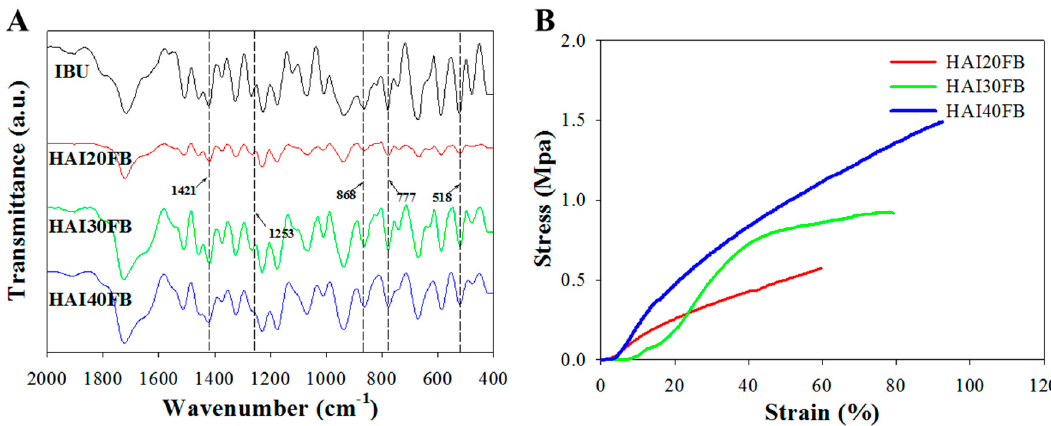
Figure 3. The FTIR spectra ( A ) and typical stress–strain curves ( B ) of the HAI20FB, HAI30FB, and HAI40FB NFMs. Table 1. The ultimate tensile stress, ultimate tensile strain, and Young’s modulus of HAIFB NFMs